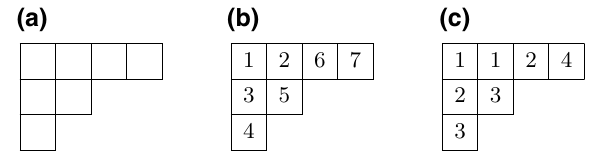
FIG. 2. Young diagrams and Young tableaux. Figure 2(a) is the Young diagram corresponding to the partition (4, 2, 1). Figure 2(b) is an associated standard Young tableau. Figure 2(c) is an associated semistandard Young tableau with numbers 1 to